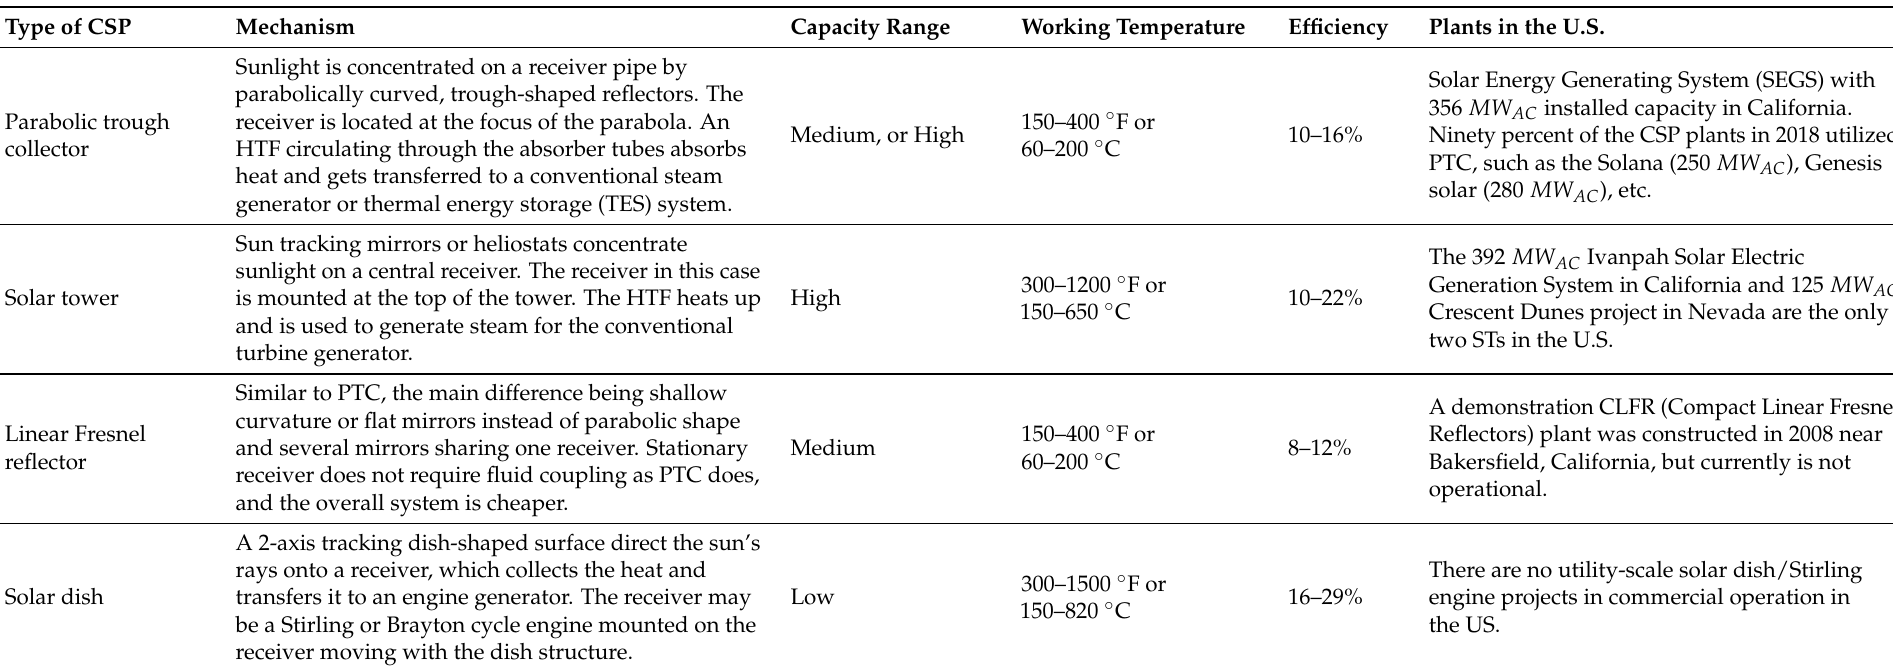
Table 1. Types of CSP